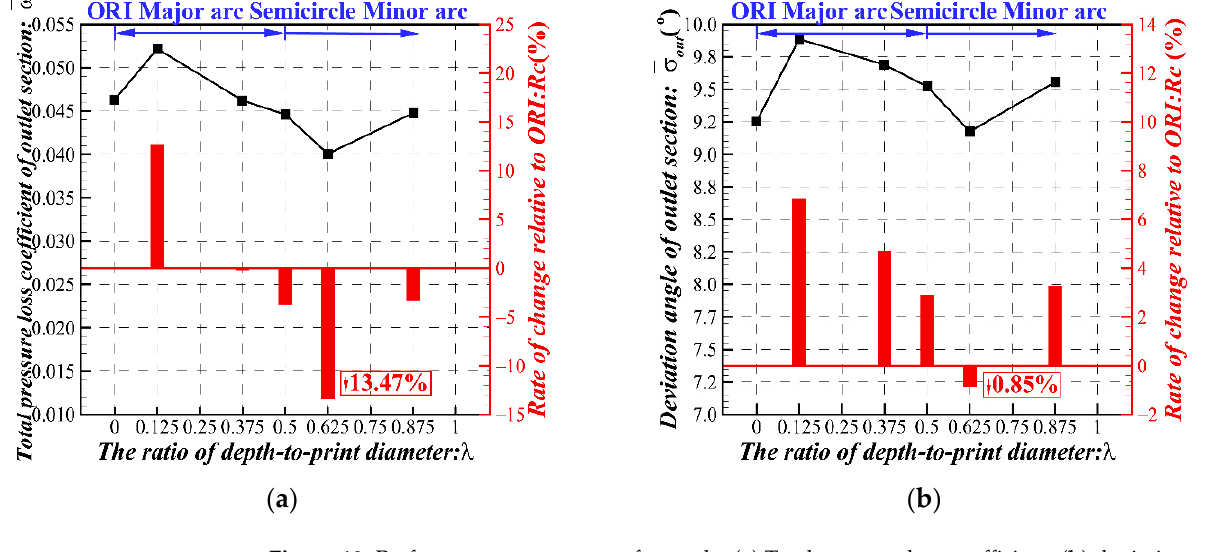
Figure 10. Performance parameters of cascade. ( a ) Total pressure loss coefficient; ( b ) deviation an- gle.